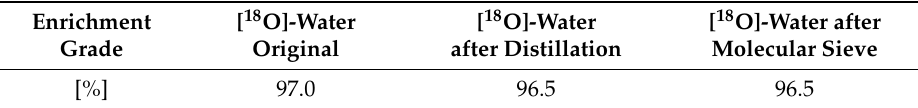
Table 4. Influence of the recovery on the enrichment